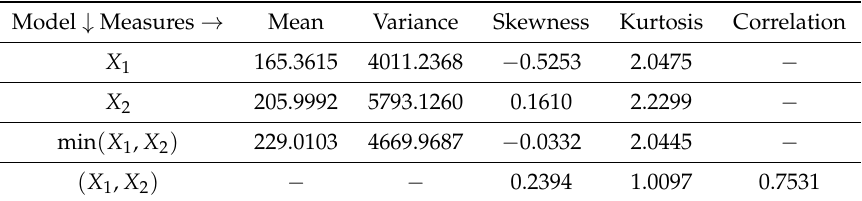
Table 18. Some descriptive statistics for data set